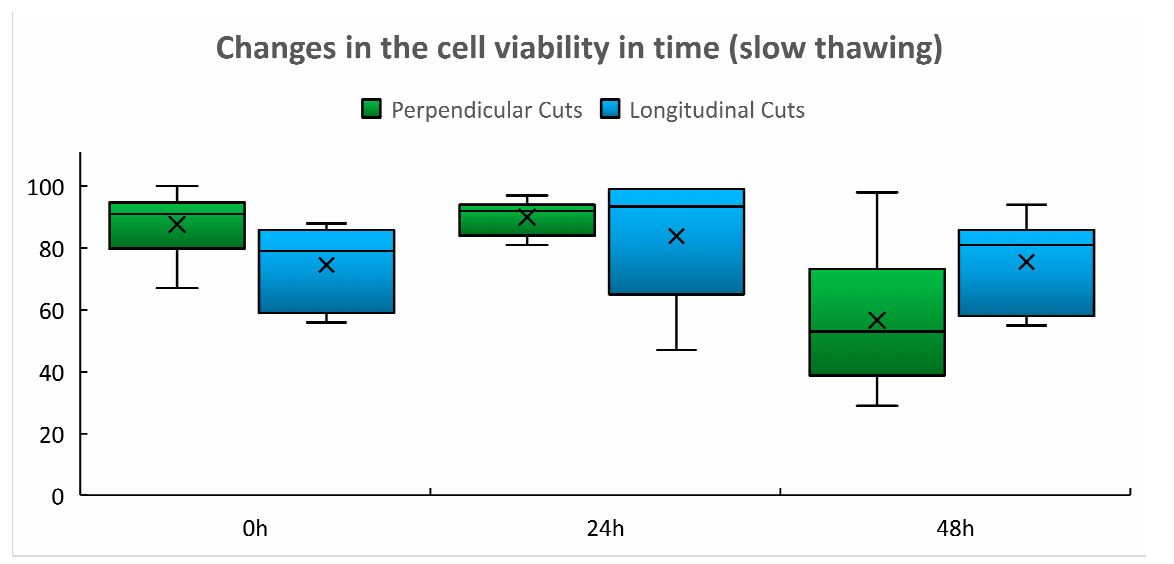
Figure 2. Changes of the post-thaw cell viability in time—slow thawing (%).